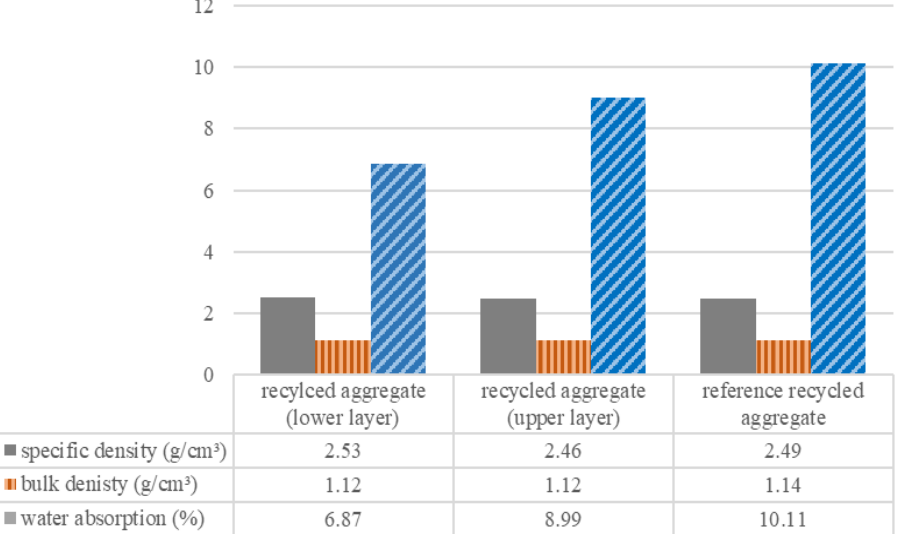
Figure 3. Characterization of CDW recycled aggregates